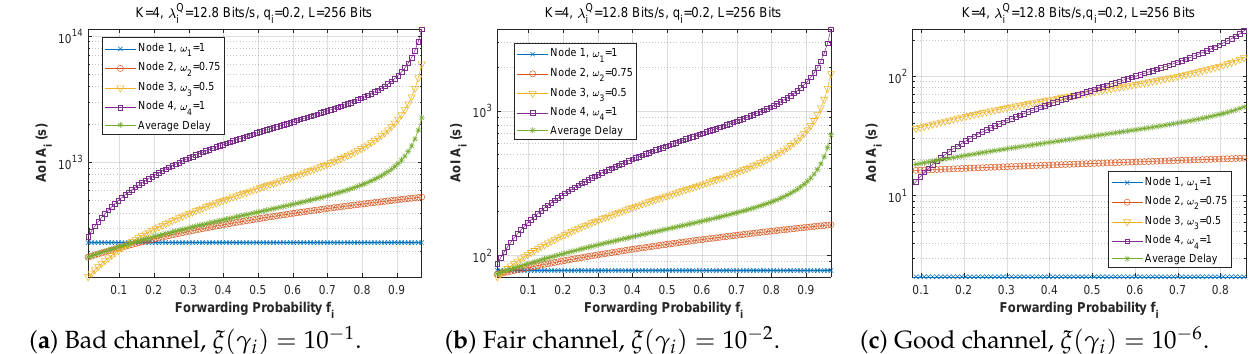
Figure 20. Setting 2: The AoI experienced at each mobile device when varying the forwarding probability with the bit error rate ξ ( γ i ) .